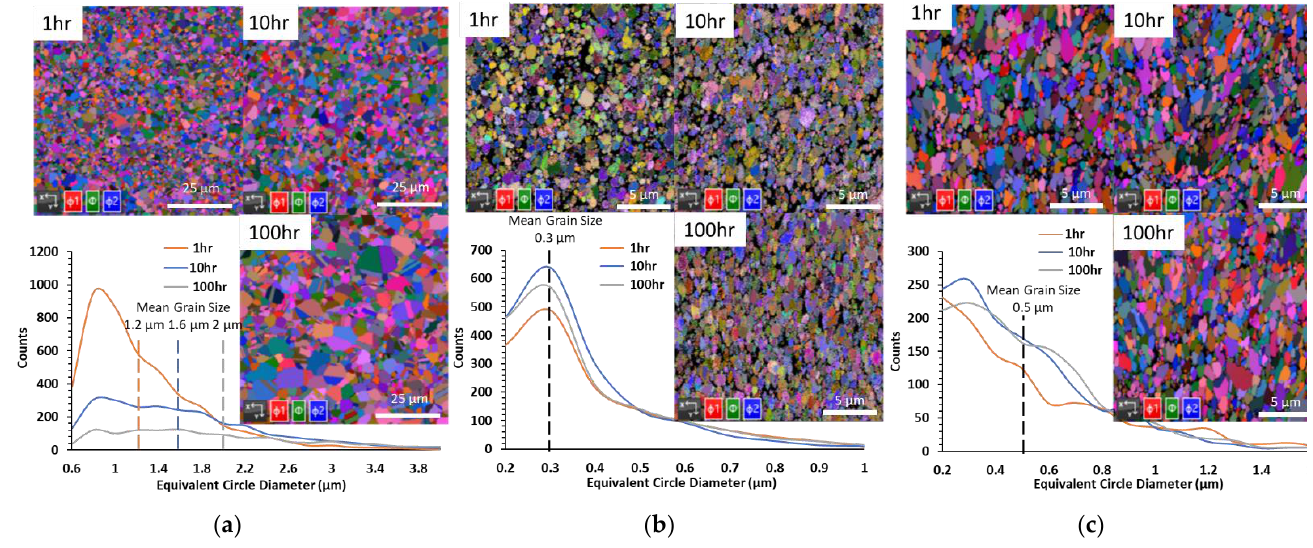
Figure 10. Grain size distribution and orientation for the double layer TBC ( a ) bond coat, ( b ) YSZ, ( c ) GZ layers.